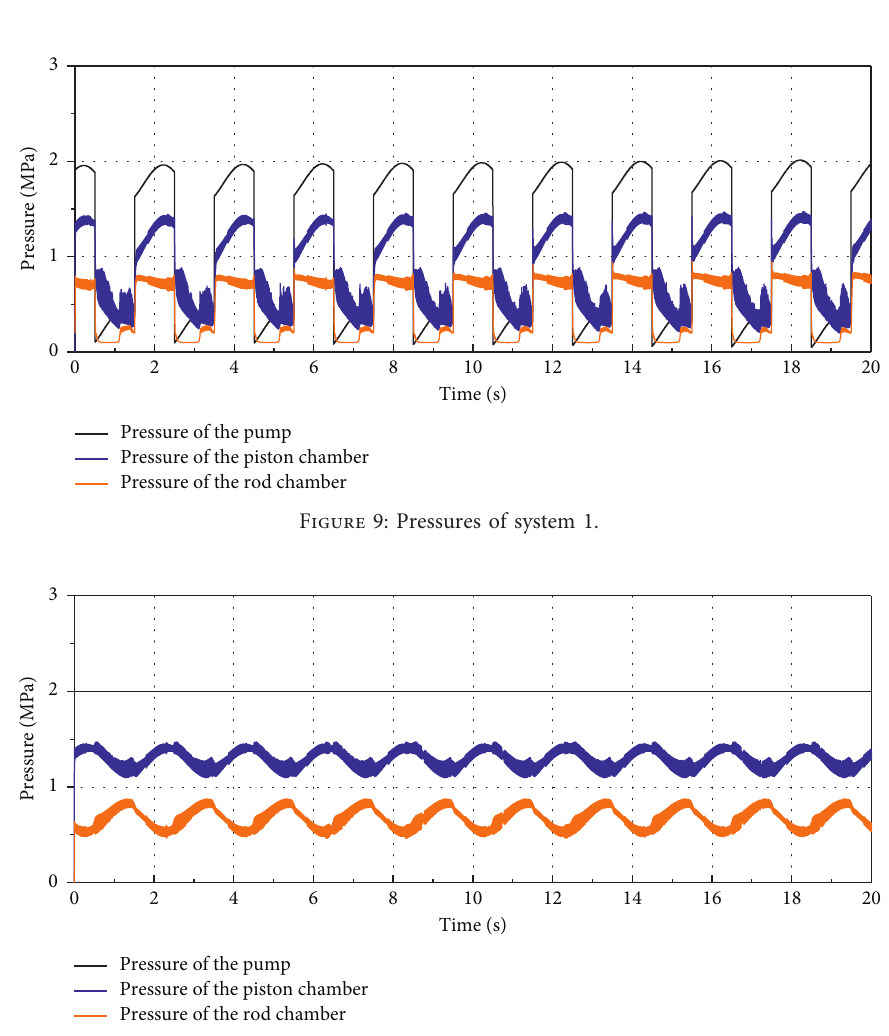
Figure 10: Pressures of system